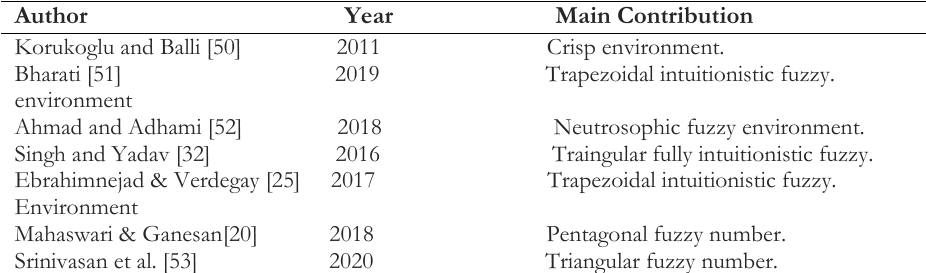
Table 1. Significance influences of the different authors towards under various